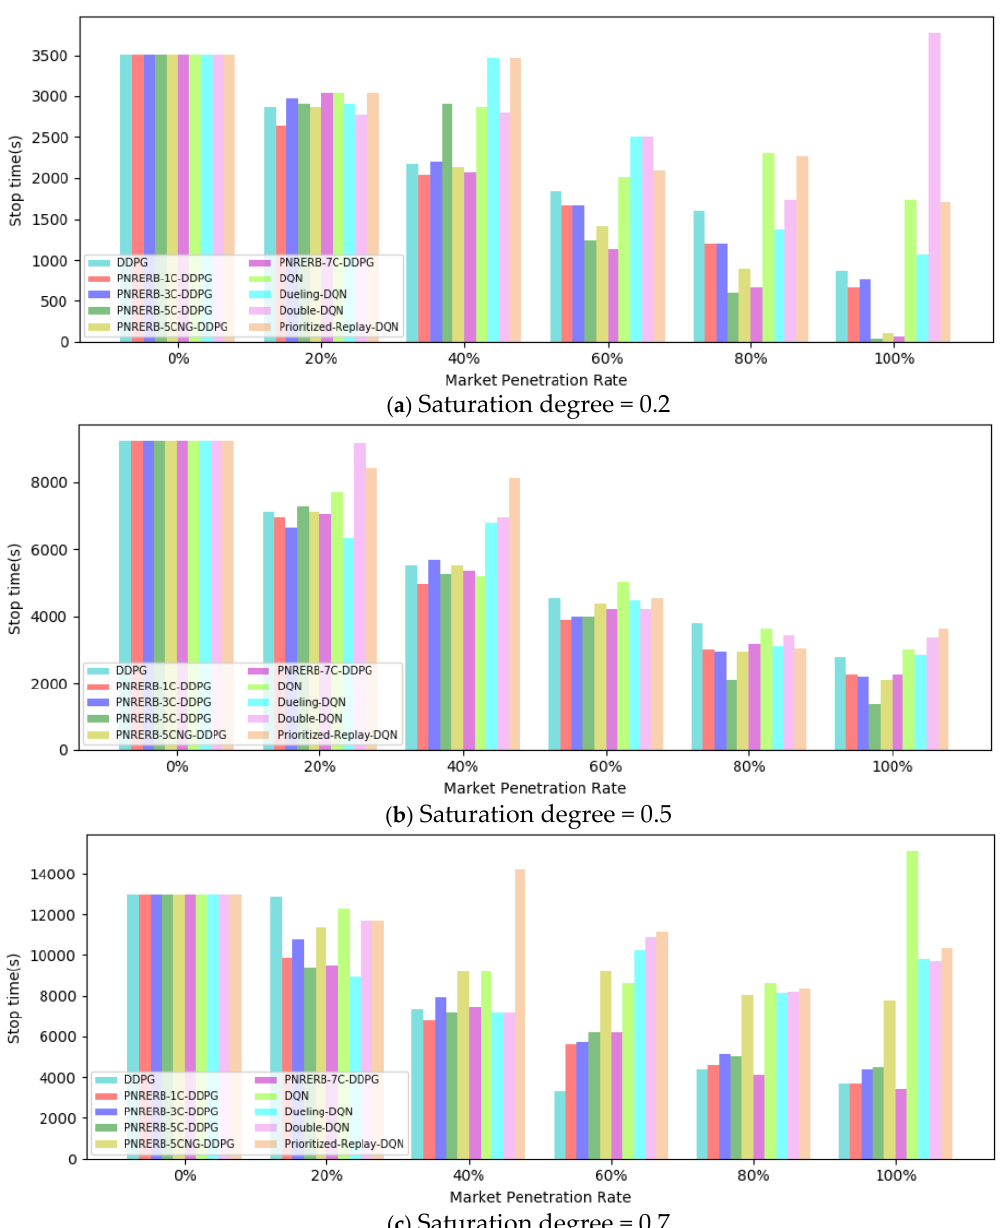
Figure 8. Comparison diagram of stop times under different CAV MPRs under saturation of 0.2/0.5/0.7.